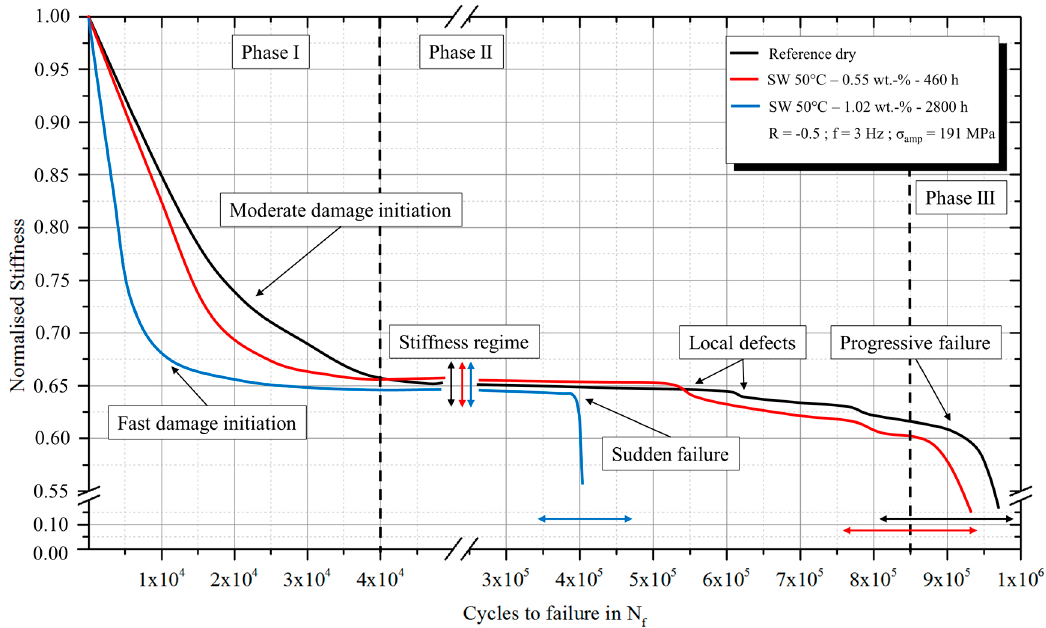
Figure 7. Schematic representation of the stiffness development during the fatigue test based on a load amplitude of 191 MPa. The exact values of stiffness and life may vary for each sample. The diagram illustrates the general trends.